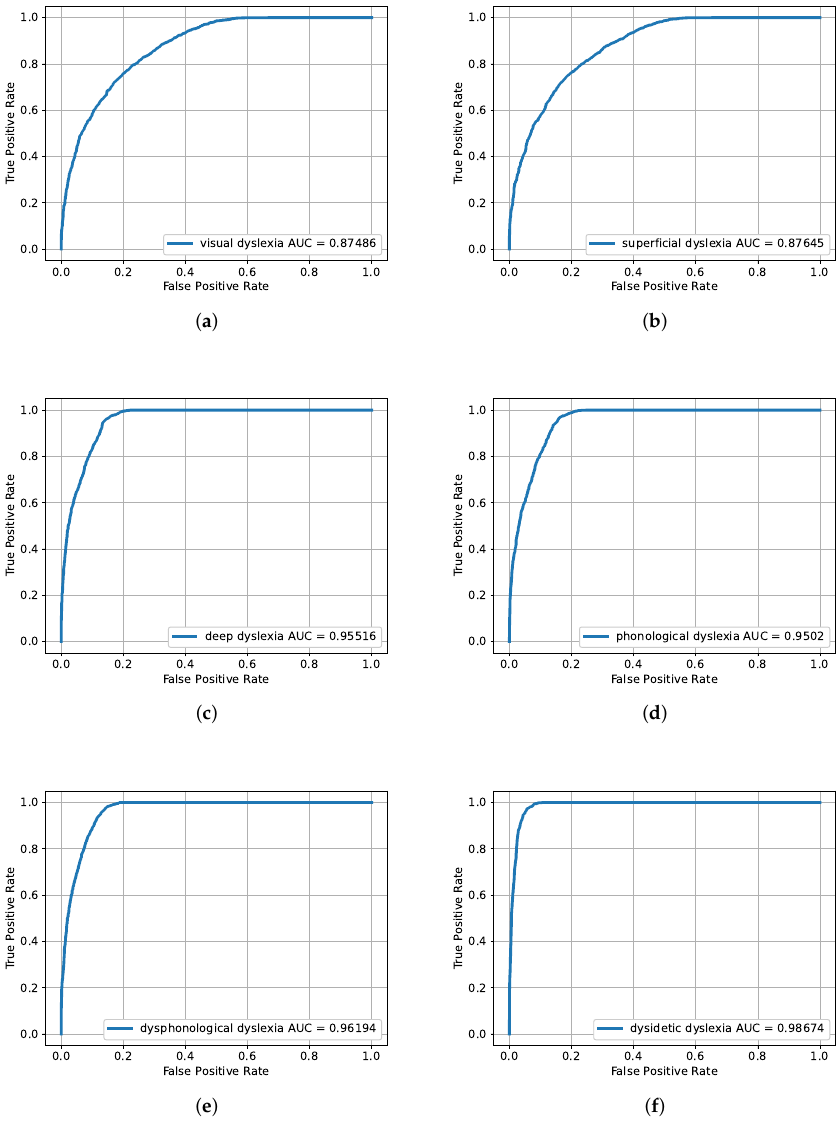
Figure 4. Experiments on real data for different kind of dyslexia, namely visual ( a ), superficial ( b ), deep ( c ), phpnological ( d ), dysphonological ( e ), dysidetic ( f